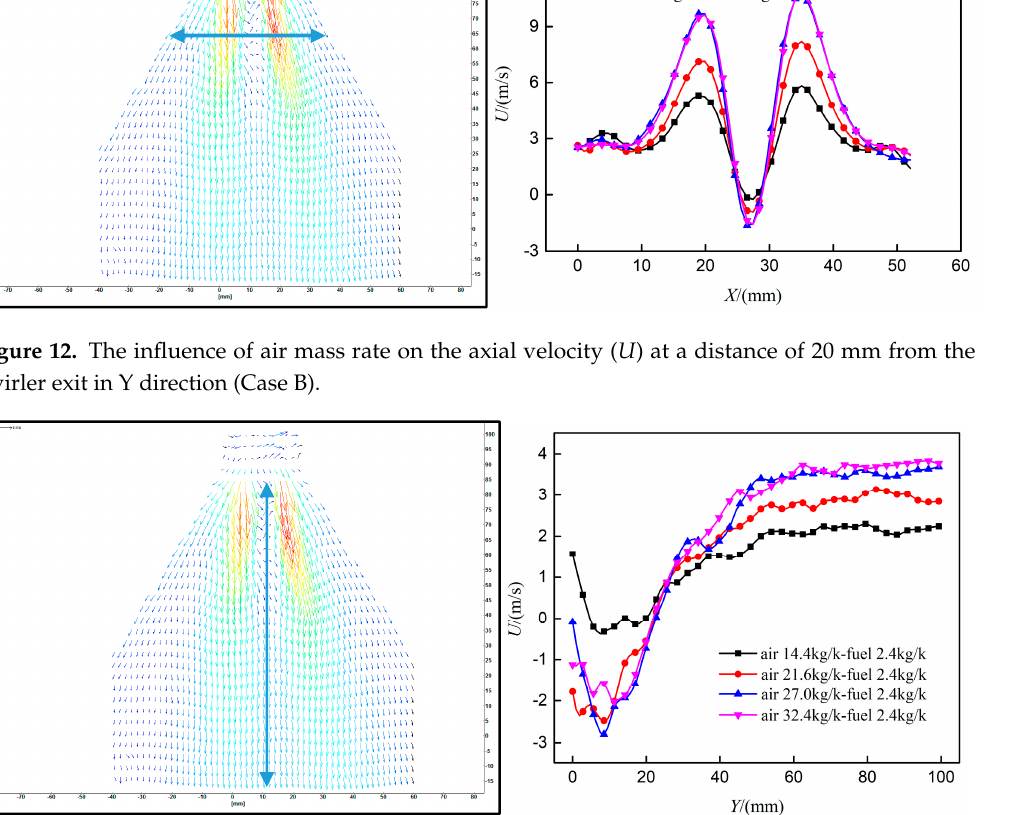
Figure 13. The influence of air mass rate on the axial velocity ( U ) at the axis (Case B).